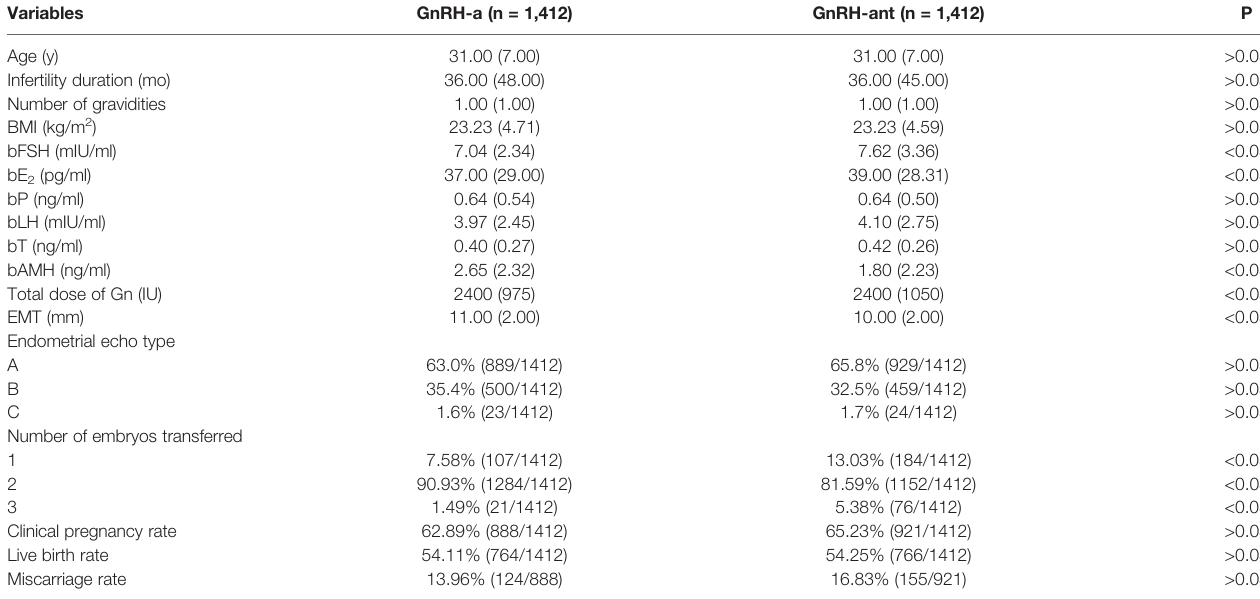
TABLE 2 | Clinical data and pregnancy outcomes in different protocols after Propensity score matching. Variables